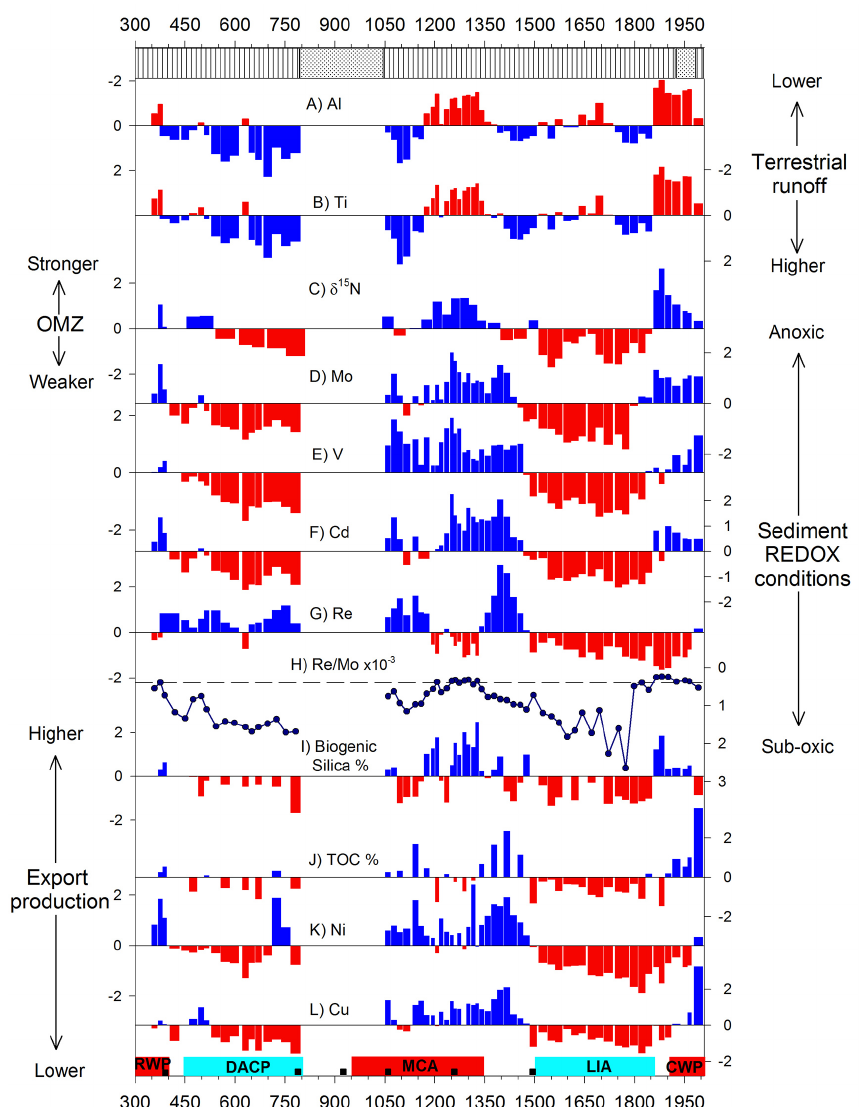
Fig. 2. Standardized values (value-average)/sd) of the proxies evaluated in the present study. (A) Aluminum (Al), (B) Titanium (Ti) proxies for terrestrial runoff. (C) δ 15 N, proxy for water column denitrification. (D) Molybdenum (Mo), (E) Vanadium (V), (F) Cadmium (Cd) and (G) Rhenium (Re), proxies for sediment redox conditions. (H) Re/Mo × 10 − 3 , proxy to differentiate euxinic ([O 2 ]=0; presence of H 2 S) versus sub-oxic conditions; the dashed line indicates the seawater value of Re/Mo=0.4 × 10 − 3 reported by Crusius et al. (1996). (I) Biogenic silica (%), proxy for siliceous export production. (J) Total organic carbon (TOC), (K) Nickel (Ni) and (L) Copper (Cu) export production proxies. The rectangle at the top of the figure represents a simplified lithology: the areas with vertical lines represent finely laminated sediments and the dotted areas represent mixed sediments or more homogeneous material. The colored boxes at the bottom of the figure indicate the Roman Warm Period (RWP), the Dark Ages Cold Period (DACP), the Medieval Climate Anomaly (MCA), the Little Ice Age (LIA) and the Current Warm Period (CWP). The age intervals of each period were taken from Lamb (1995) and Graham et al. (2011). The small boxes at the bottom of the figure indicate the position of the samples that were dated by 14 C. The data corresponding to the LIA and CWP were lumped into intervals of ∼ 20years to fit the sample resolution of the older